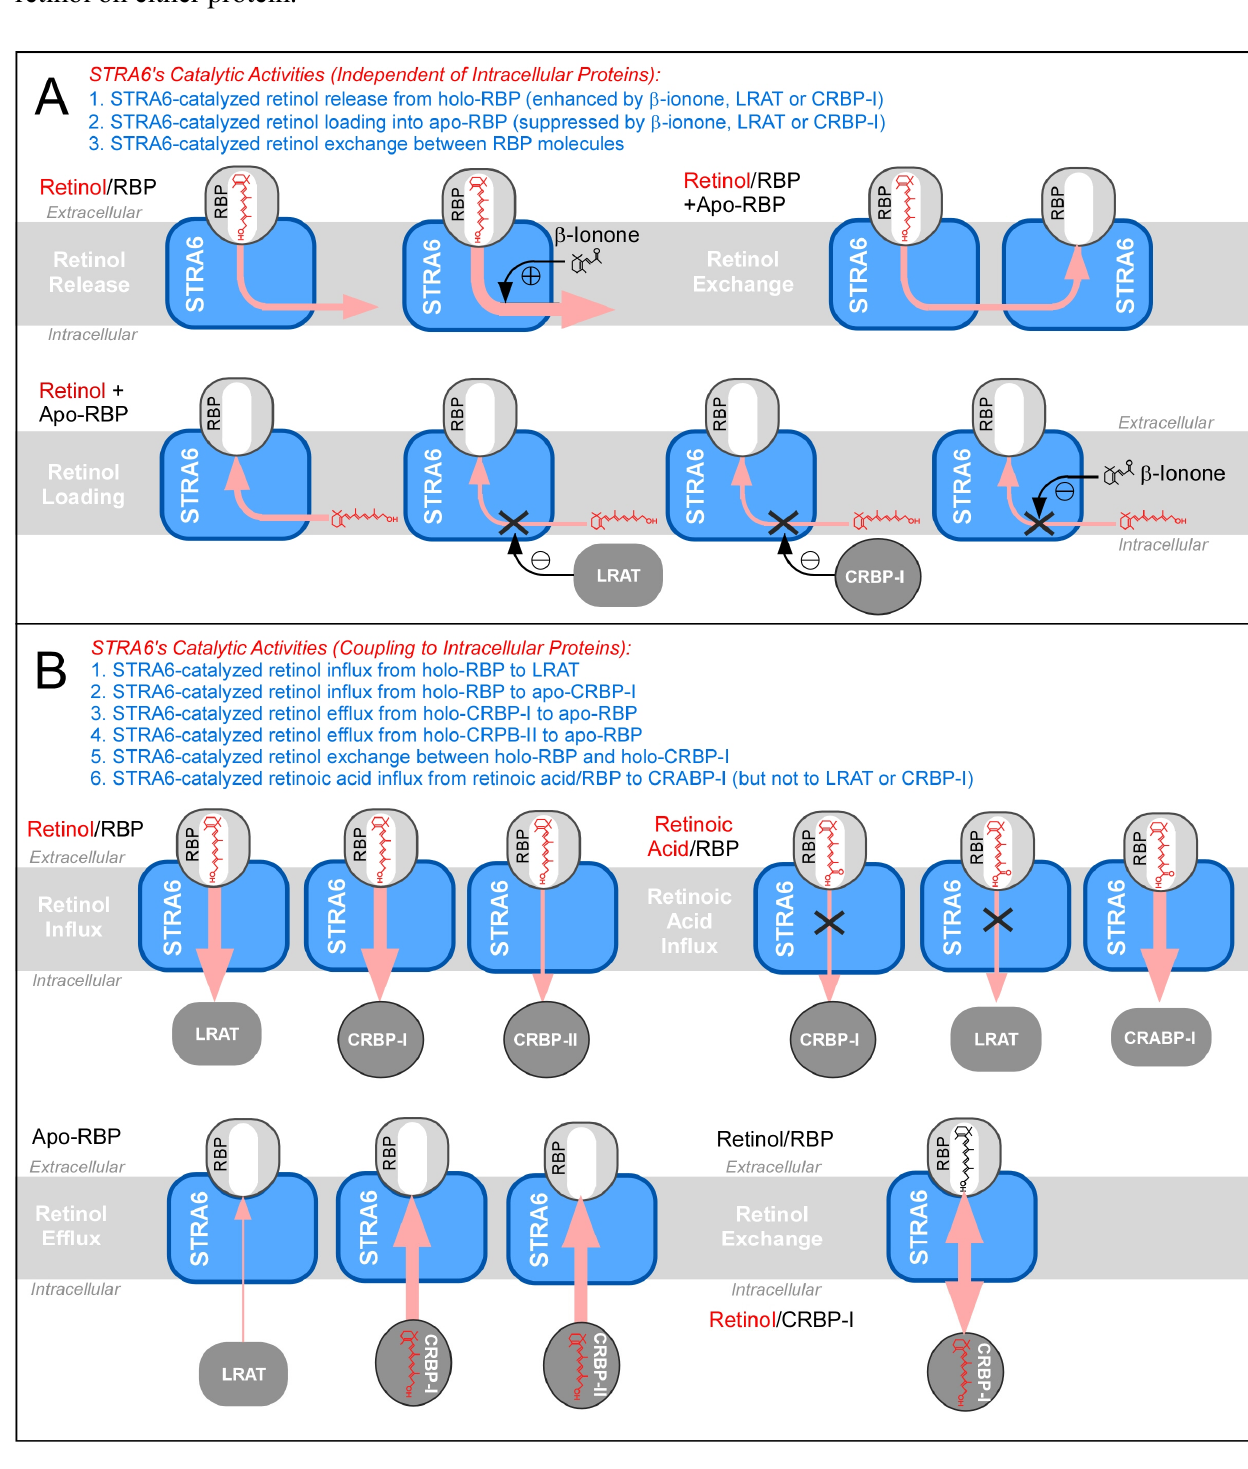
Figure 4. Schematic diagrams of the diverse catalytic activities of STRA6. ( A ) Summary of STRA6’s catalytic activities independent of intracellular proteins and the influences (stimulation or inhibition) of intracellular proteins on these activities. ( B ) Summary of STRA6’s activities that couple to intracellular proteins. The directions of retinol transport are indicated by the light red arrows. The efficiency of retinol transport is indicated by the thickness of each